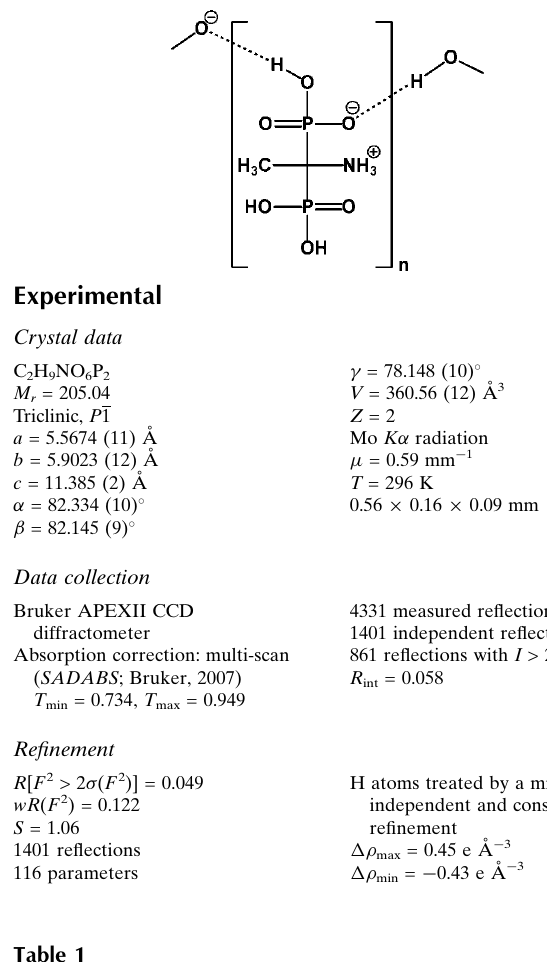
Hydrogen-bond geometry (A˚ , (cid:3)